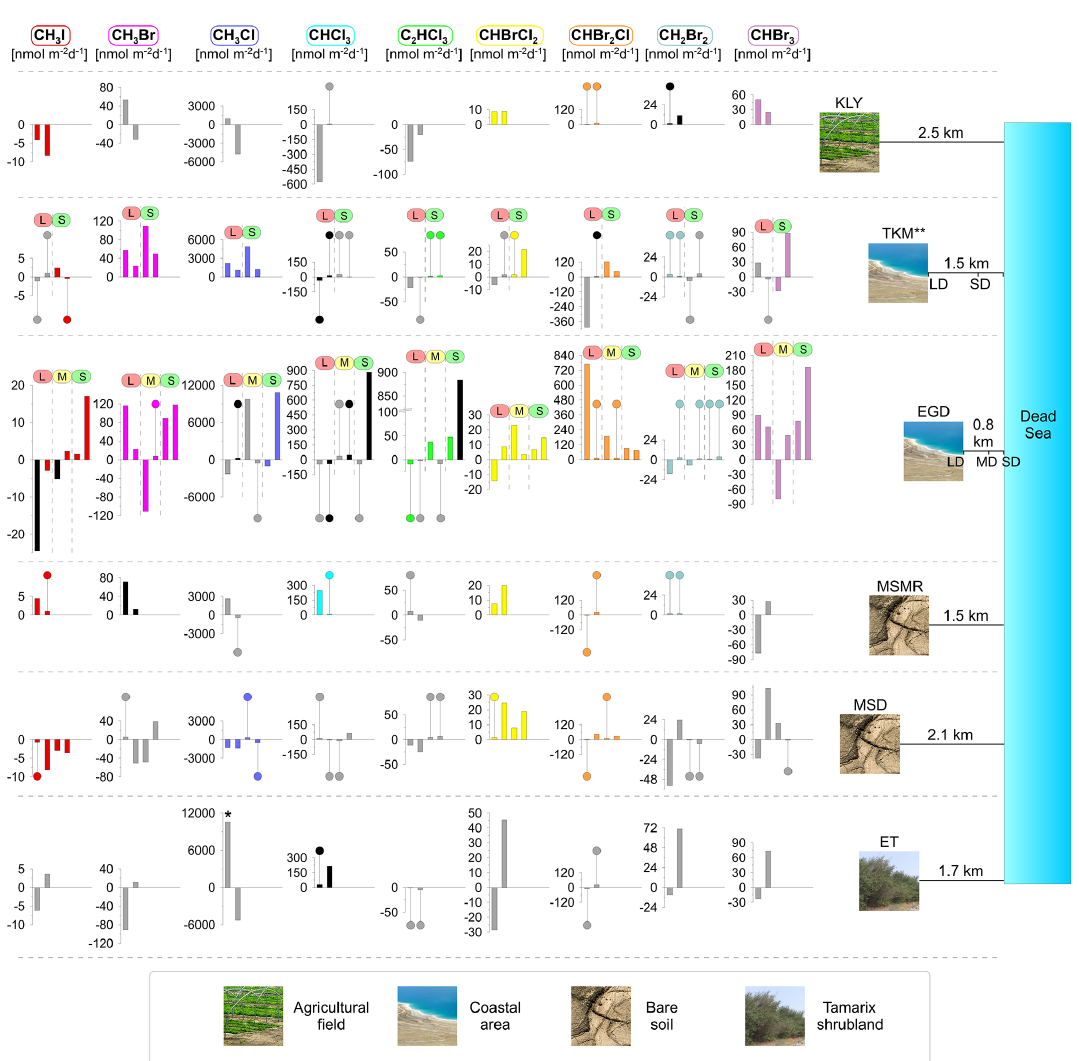
Figure 4. Bar graphs of VHOC fluxes from the different site types, organized by relative orientation to the Dead Sea and with visual indicators of surface cover type. Colored bars represent measured fluxes associated with p values <0.05. Gray and black bars indicate fluxes associated with no clear statistical significance (black for 0.05< p <0.1 and gray for p >0.1). Circles with drop lines are used to mark fluxes with relatively low values. Different colors refer to different VHOCs as indicated at the top of the figure. The different site types are indicated in the legend. S, M and L indicate short, medium and long distance of the measurement site from the seawater for the coastal sites (SD, MD and LD, respectively; see Sect. 2.1.1). See Table 1 for measurement sites and measurement abbreviations. ∗ CH 3 Cl flux calculation excludes one sample in TMRX–ET-1 (see Sect. 2.1.2). ∗∗ Flux calculation excludes one sampling canister in COAST–TKM-LD (see Sect.